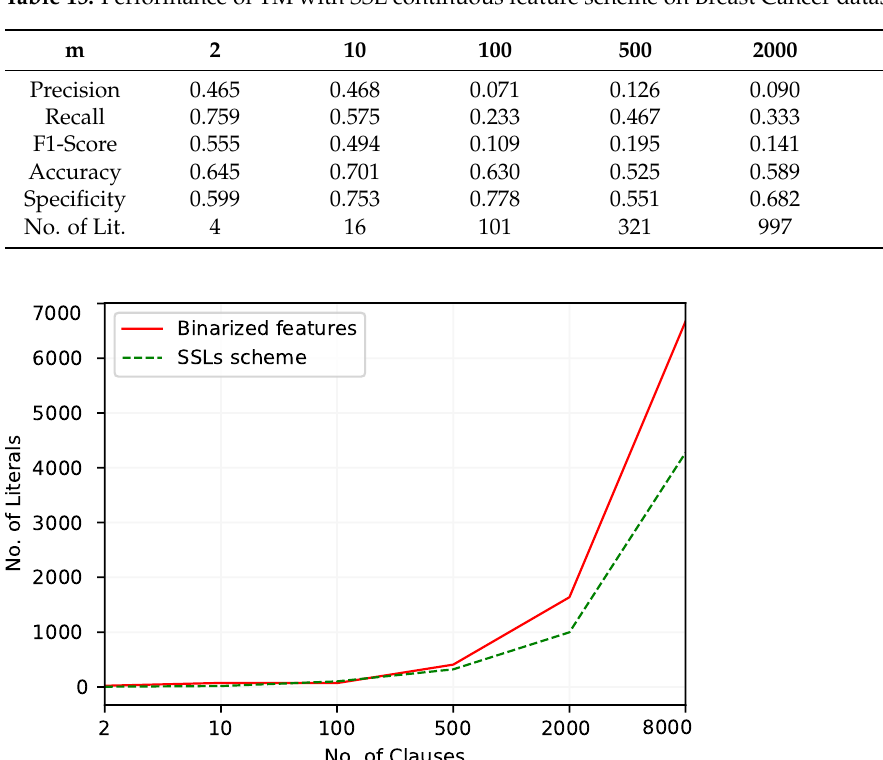
Table 15. Performance of TM with SSL continuous feature scheme on Breast Cancer dataset.